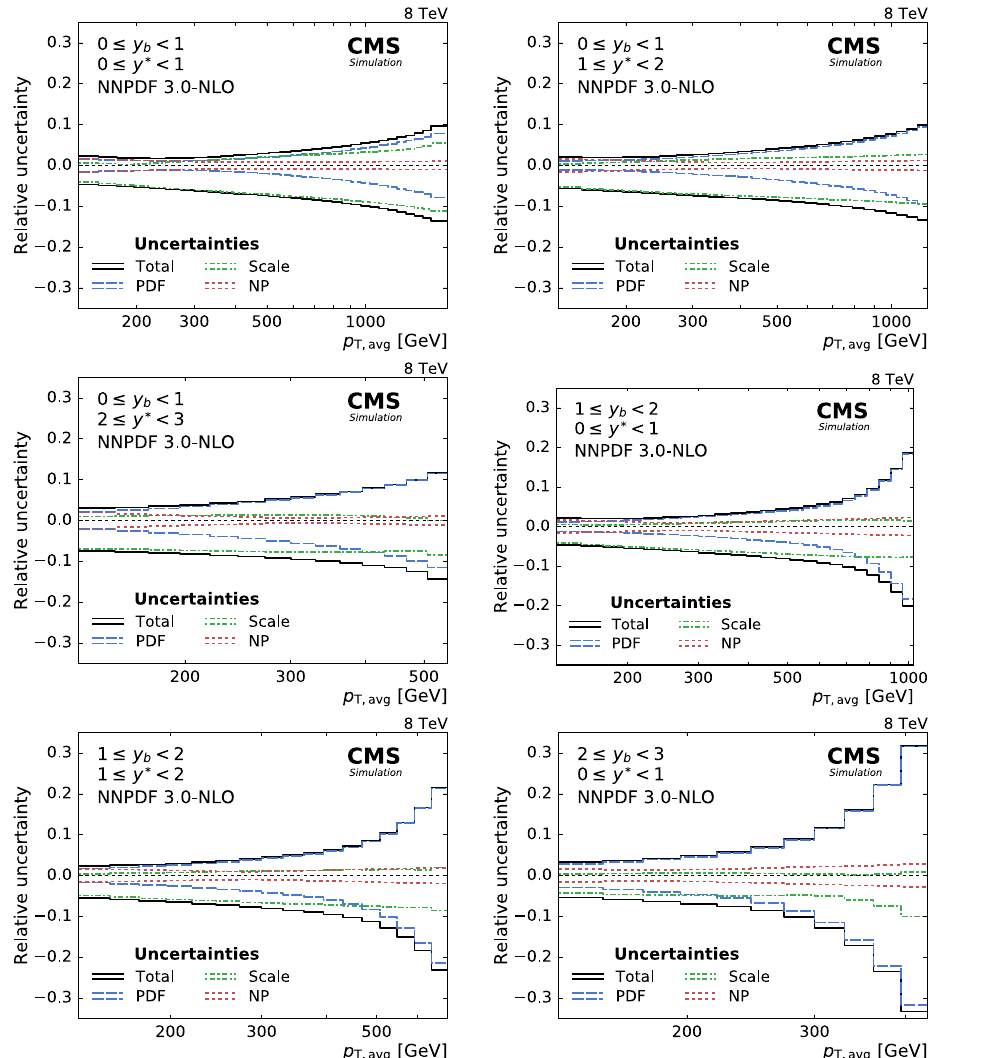
Fig. 5 Overview of the theoretical uncertainties. The scale uncertainty dominates in the low- p T , avg region. At high p T , avg , and especially in the boosted region, the PDFs become the dominant source of